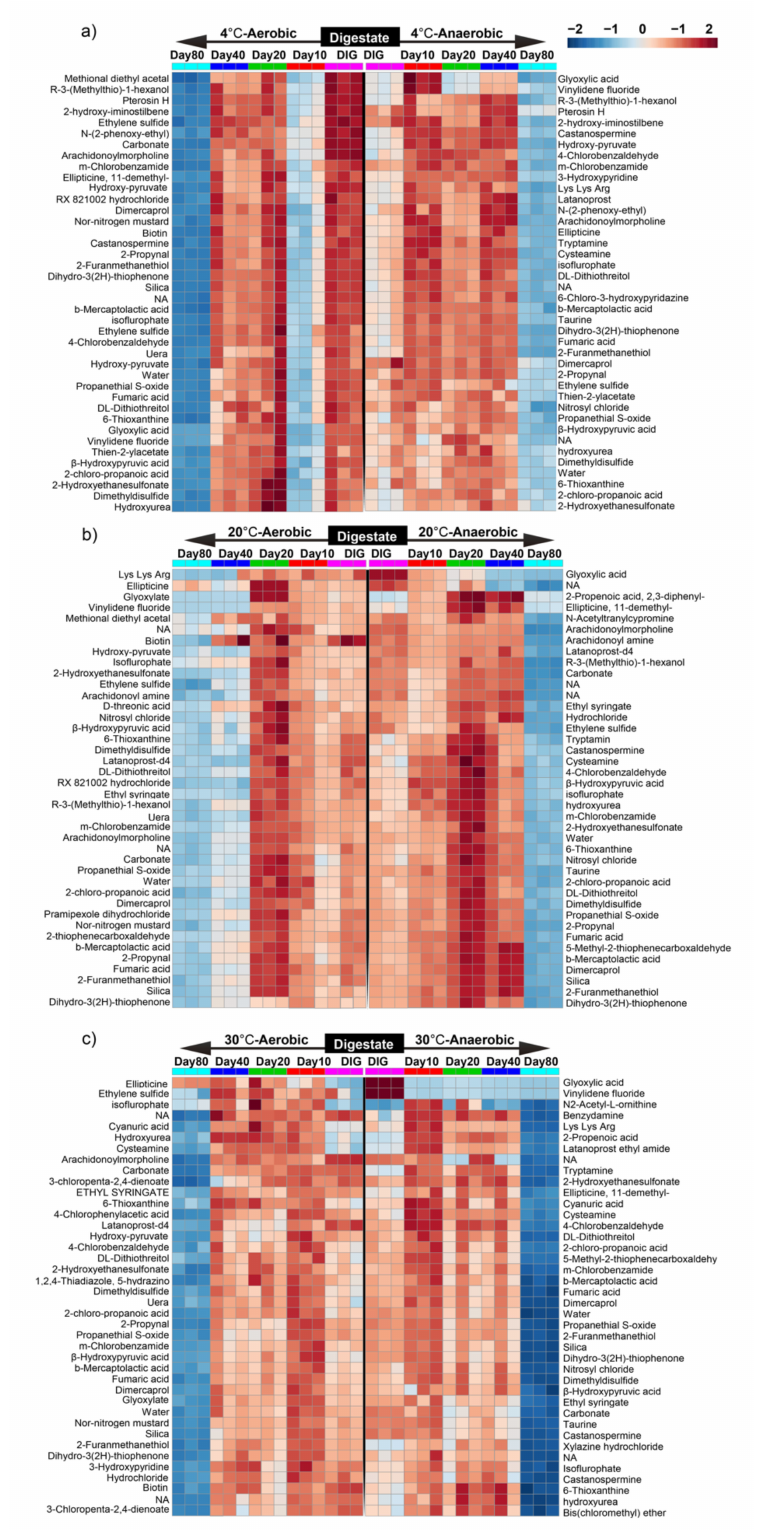
Figure 2. Heat map of the hierarchal clustering analysis of differential metabolites ( p < 0.05) of diges- tate stored at ( a ) 4 ◦ C aerobic versus 4 ◦ C anaerobic, ( b ) 20 ◦ C aerobic versus 20 ◦ C anaerobic, and ( c ) 30 ◦ C aerobic versus 30 ◦ C anaerobic. Colored cells correspond to the concentration value (samples in column and compounds in row). The data presented were normalized and subject to a t -test/ANOVA, and features were standardized to